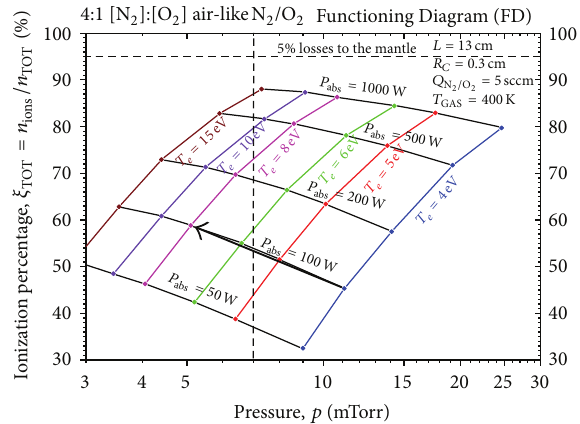
Figure 18: “Functioning Diagram” (FD) for the feeding of 5sccm for the “core” region of an air-like fed